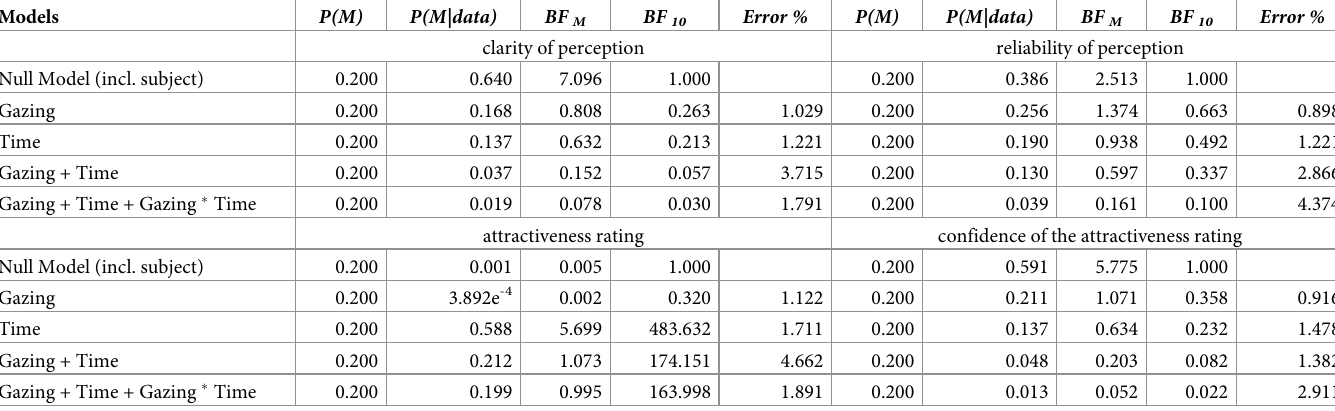
Table 3. Bayesian repeated measures ANOVA of uncertainty of perception (two factors) and attractiveness rating (two factors). Models